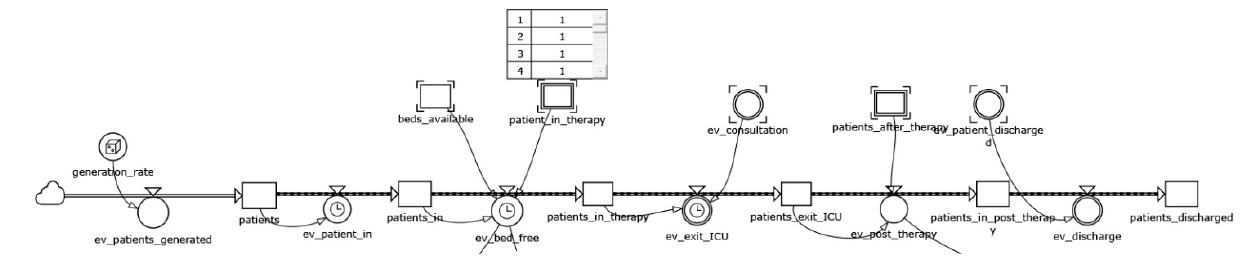
Figure 1. The Patient